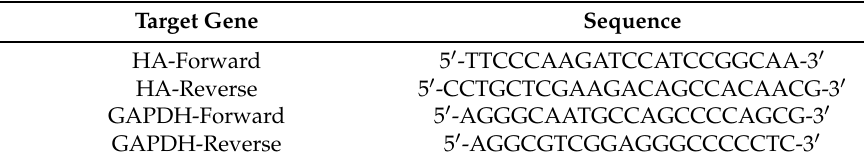
Table 3. Primer sequences for quantitative real time